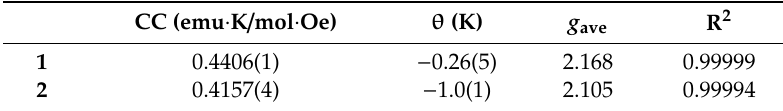
Figure 6. The magnetic susceptibility plotted as χ T(T) (left axis) and 1 / χ (T) (right axis) of 1 (top) and 2 (bottom). Table 4. Fitted parameters to the Curie–Weiss Law for 1 and 2 . g ave was calculated from the fitted value of the Curie constant (CC).